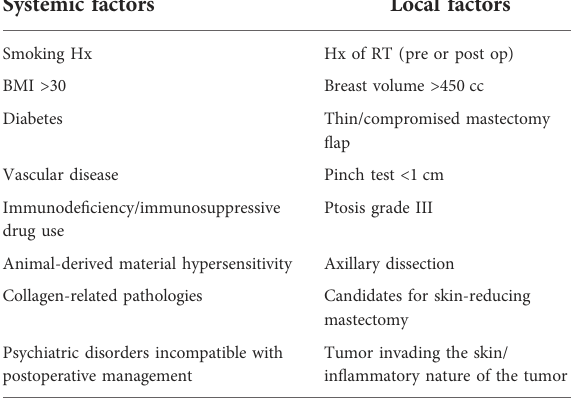
TABLE 3 Summary of risk factors and exclusion criteria reported in the literature speci fi c for Braxon®-assisted prepectoral breast